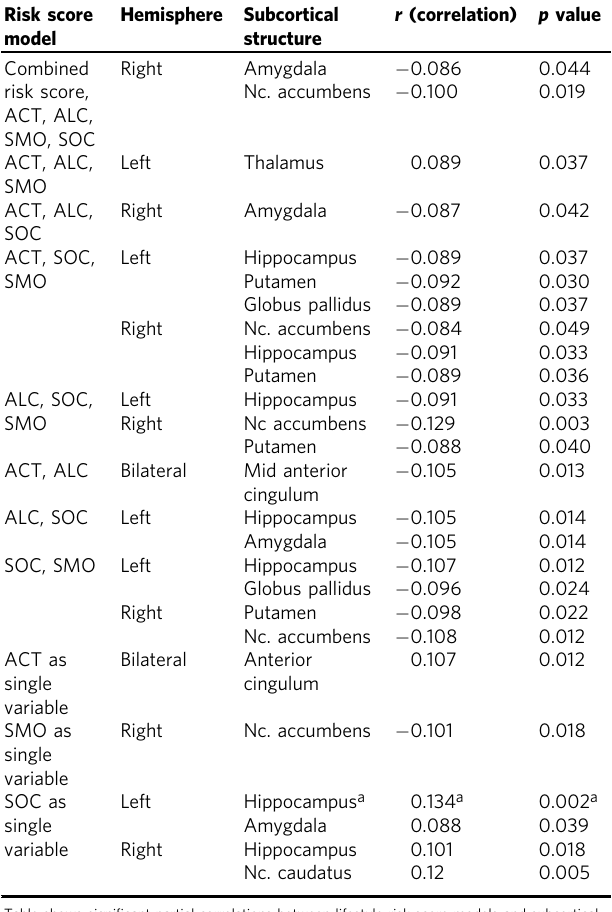
Table shows signi fi cant partial correlations between lifestyle risk score models and subcortical structures, corrected for age, gender, and total intracranial volume, n = 549 complete correlation matrix can be found in Supplementary Data